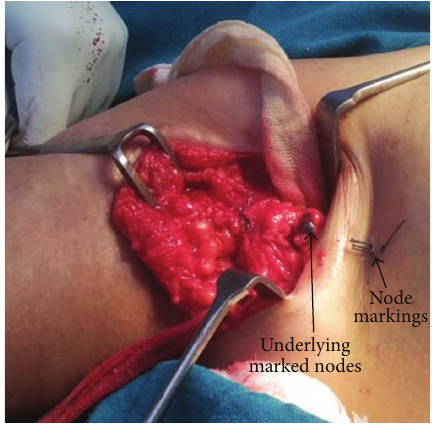
Figure 2: Sampling of the marked